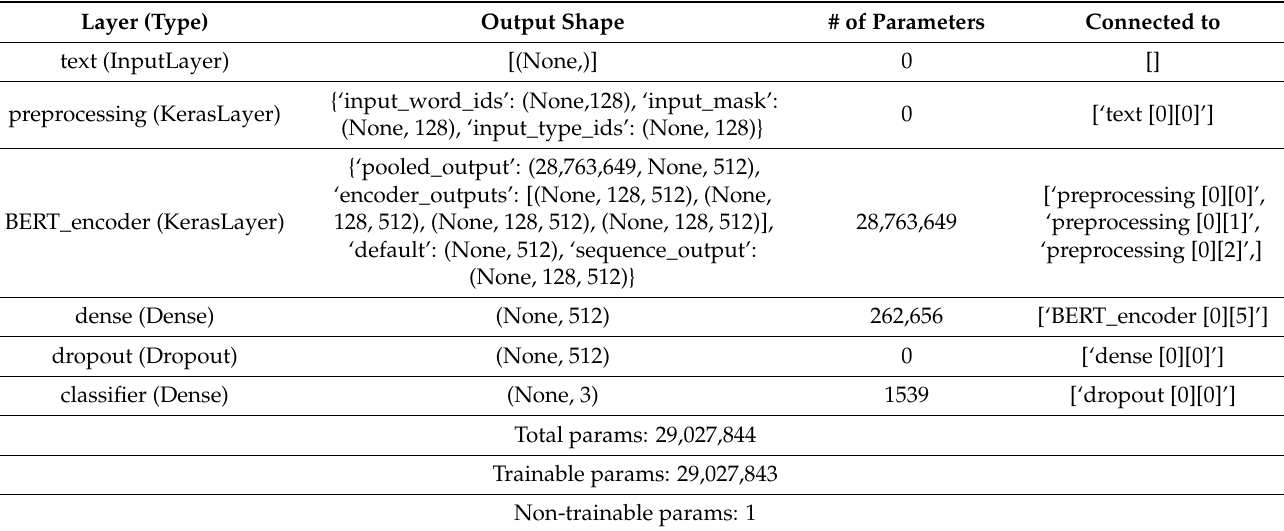
Table 6. BERT + MLP model summary.